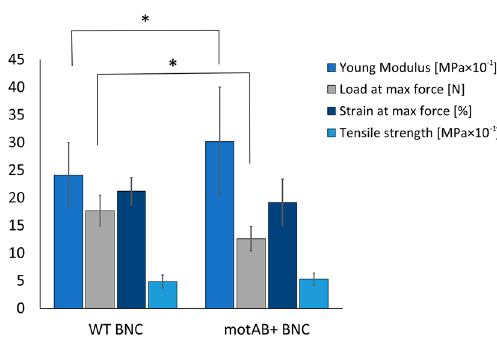
Figure 3. Mechanical parameters of native (WT BNC) and mutant–derived (motAB+ BNC) bacterial cellulose membranes. Significance calculated with t -test; * denotes p < 0.05.